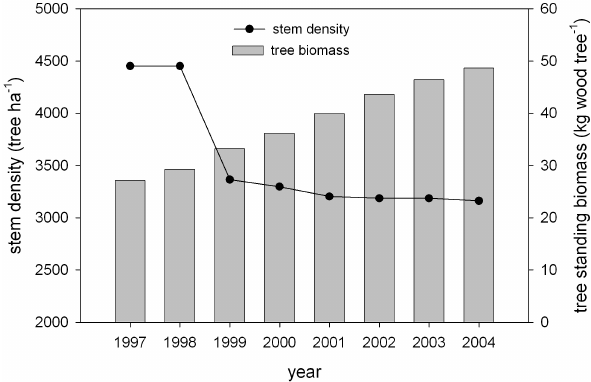
Fig. 1. Stem density and tree standing wood biomass at the beech stand of Hesse during the study